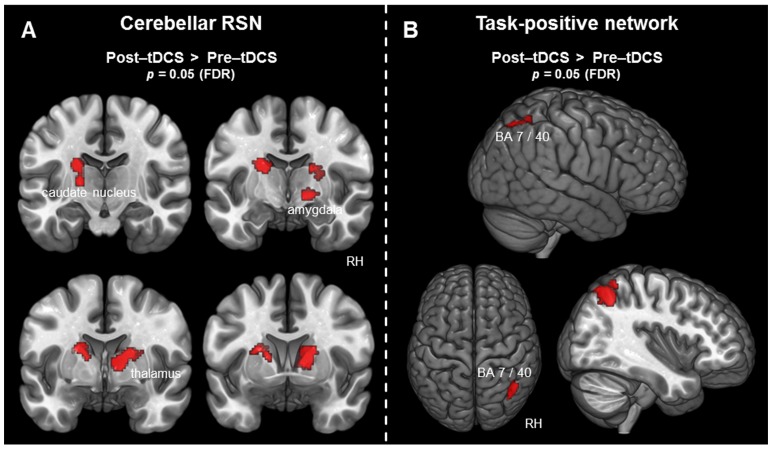
Voxel-wise difference maps for the cerebellar RSN and the TPN.Activity detected in the context of the cerebellar RSN and the TPN is displayed at a cluster-level threshold of p<0.05 (FDR corrected) and projected on the MNI template brain (ICBM 152). A) Areas associated with the cerebellar RSN exhibiting increased activity following tDCS. B) Areas associated with the TPN exhibiting increased activity following tDCS. (BA =  Brodmann area; FDR =  false discovery rate; RH =  right hemisphere; RSN =  resting-state network).